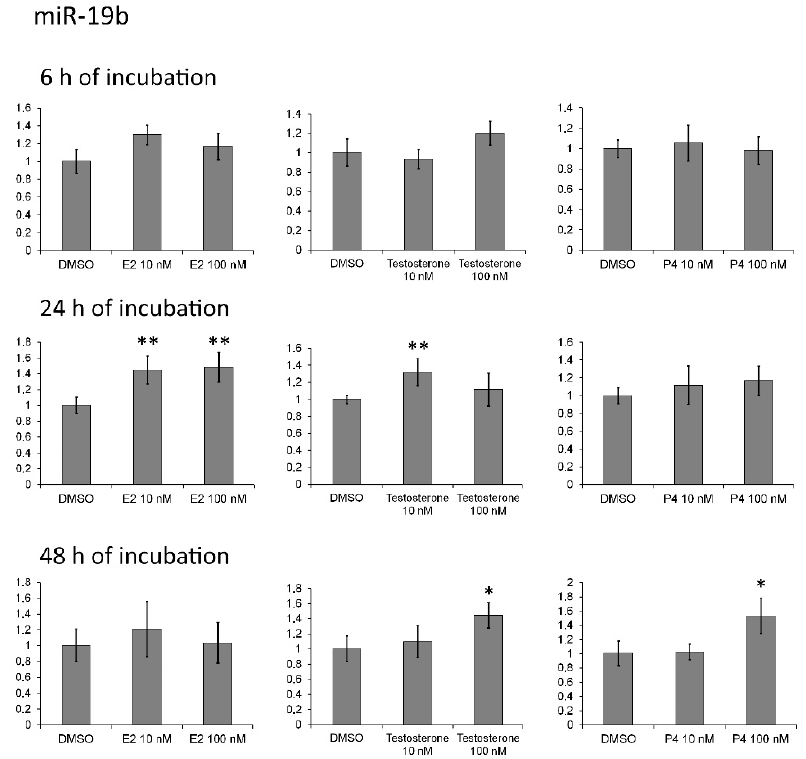
Figure 2. Changes in relative level of miR-19b in MCF-7 cells exposed to estradiol (E2), progesterone (P4) or testosterone. The Y -axis shows the ratio of the miRNA level in the cells treated with a hormone to the miRNA level in the cells treated with DMSO. Each value is the mean of three independent experiments. * Significant differences from the control ( p < 0.05); ** p < 0.01. The levels of miR-23a, miR-27a, miR-190b, miR-21, miR-126, miR-378, miR-423, miR- 149, miR-193b, miR-324, miR-342, and miR-19b did not change in MDA-MB-231 cells treated with